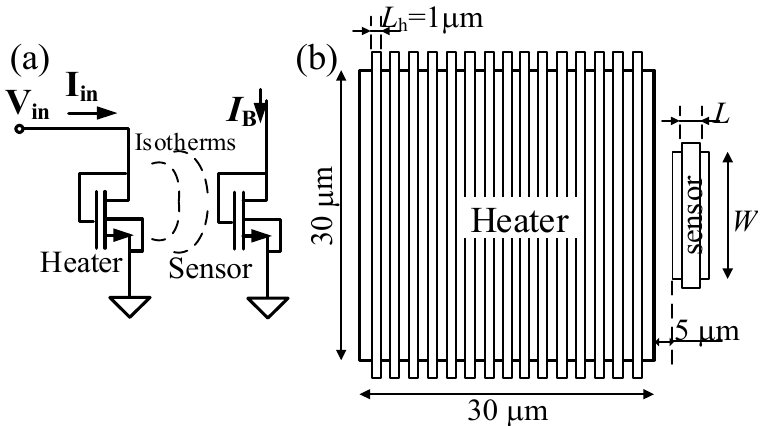
Figure 4. ( a ) Schematic of the nMOS heater and the temperature transducer T 1 . ( b ) Layout floorplan. Multiplying Equations (4) and (5), the power dissipated by the heater in the frequency domain can be described as the sum of different spectral components. If we focus on the spectral component at the frequency f i (called p fi ), it can be written as: